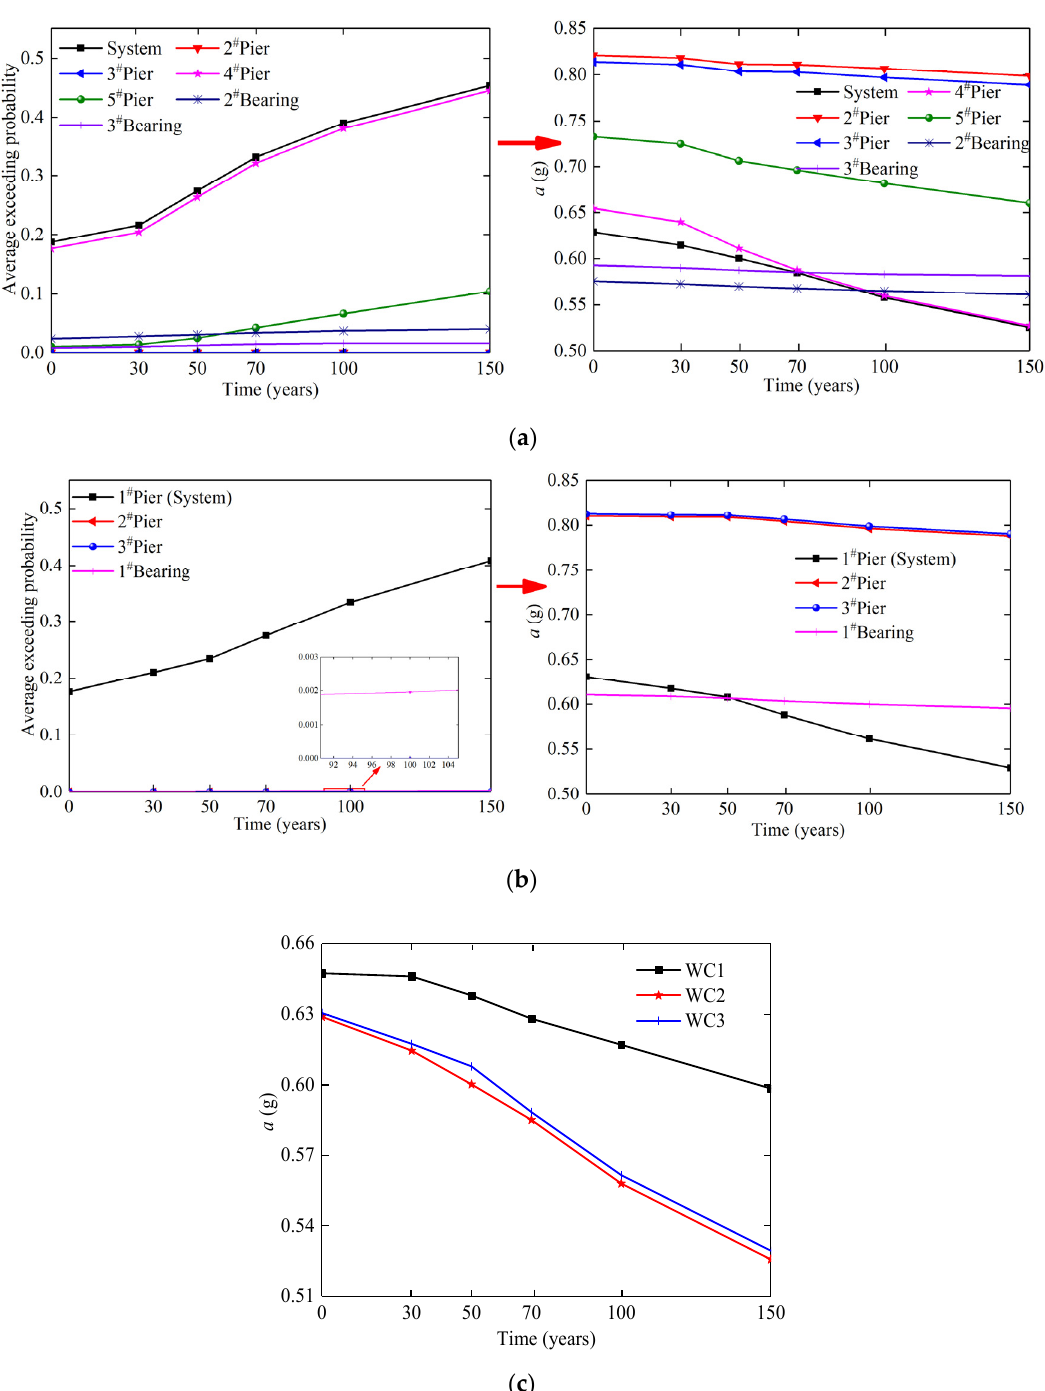
Figure 14. A value of each working condition: ( a ) Fragility analysis of WC2; ( b ) Fragility analysis of WC3; ( c ) Comparison of each working condition.